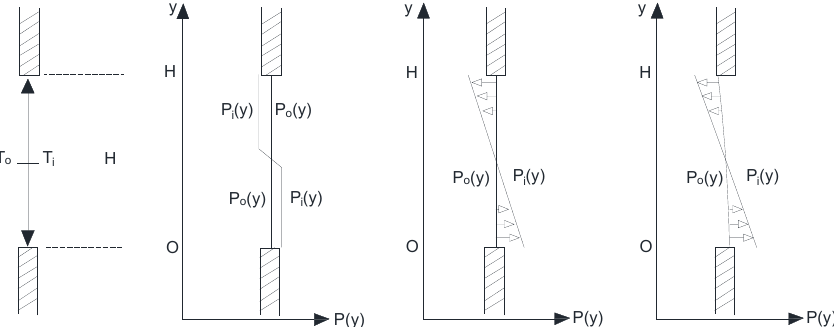
Figure 5. Scheme of the pressure distribution at the opening, with (left to right) first-order, second- order, and third-order distributions, adapted from Boulard and Baille [17] and Roy et al. [123]. The first-order assumption was verified via experiments by Boulard and Baille [17], leading to the ventilation rate function (Equation